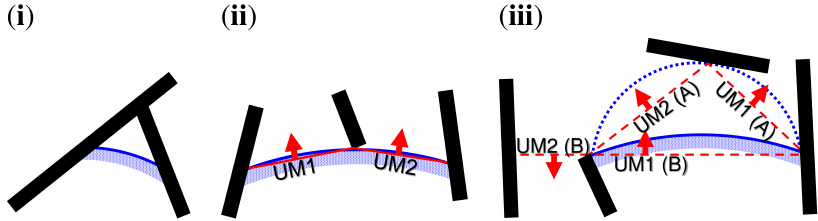
Figure 4. Illustration of the three different scenarios and the splitting of the stable meniscus in two unstable menisci (UM1 and UM2) at the end of a path: ( i ) a dead end is reached, and no unstable meniscus (UM) is established; ( ii ) a third object interrupts the meniscus; and ( iii ) the meniscus outruns the traversed object, and two different possible scenarios are considered (A and